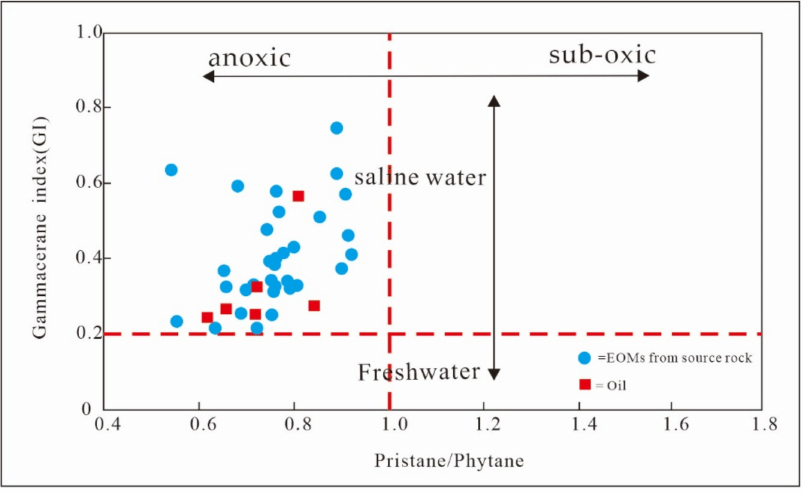
Figure 10. Plot of the Gammacerane index and Pristane/Phytane of the extracted oil samples, adapted from [16].